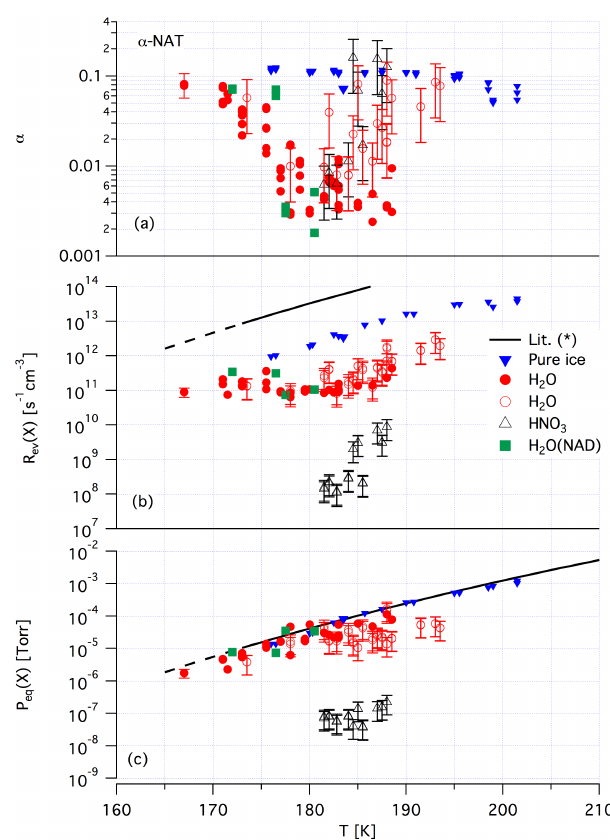
Figure 2. Synopsis of kinetic results for α -NAT and NAD using H 2 O as a probe gas in PV experiments and H 2 O and HNO 3 in two- orifice (TO) experiments. Full symbols represent PV experiments, and empty symbols represent TO experiments. The different sym- bols are coded in panel (b) . The calculated relative error for PV experiments is 30%, whereas for TO experiments we estimate a relative error of 60%. Examples of the amplitude of the errors are reported for selected points. The black line shows results from Marti and Mauersberger (1993) with R ev (H 2 O) of pure ice calculated for the system in use using α =